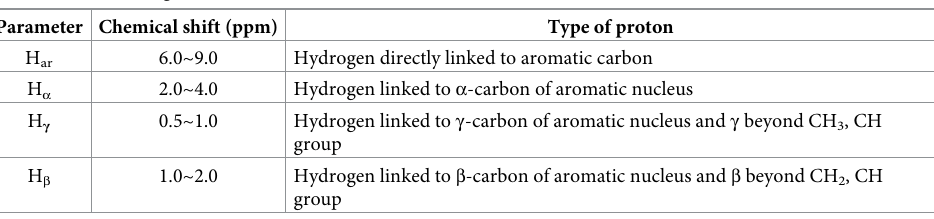
Table 2. Proton assignment in 1 H-NMR [47,48].